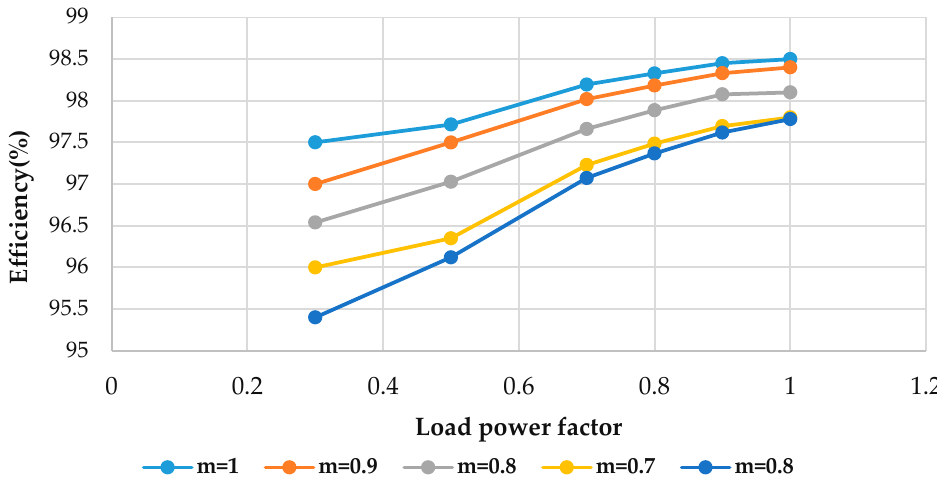
Figure 13. Efficiency versus load power factor curve of the proposed fault-tolerant MLI.